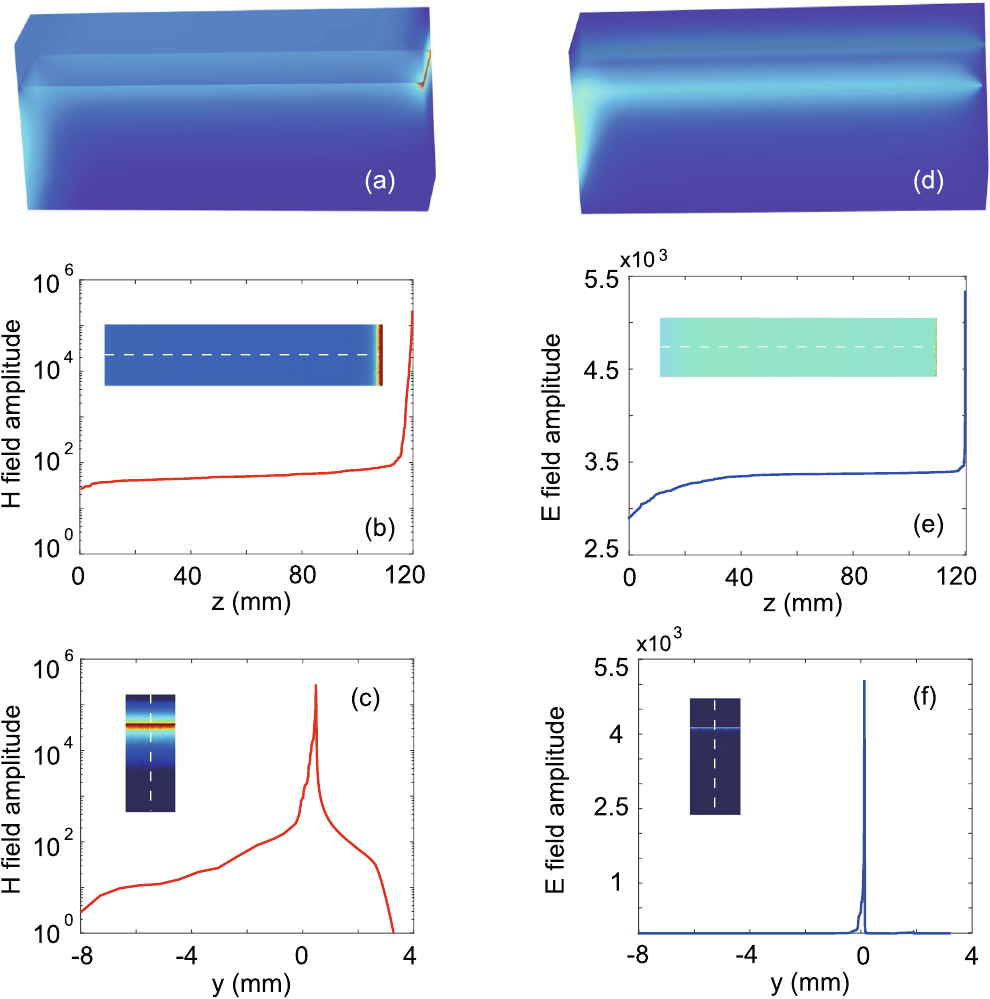
Figure 3. Simulated field amplitudes for the complete trapping of one-way propagating wave. ( a ) H amplitudes. ( b ) Distribution of H amplitude along the central line of the YIG surface. The inset is a horizontal cutting slice in ( a ) at y = 0. ( c ) Distribution of H amplitude along the y axis at a distance of 0.02 mm before the terminal end. The inset is a vertical cutting slice in ( a ) at z = 119.98 mm, where the center of the hotspot is located. ( d – f ) E amplitude versions corresponding to ( a – c ), respectively. The operation frequency is f = 5.6 GHz, ν = 10 − 3 , and the other parameters are the same as in Fig.